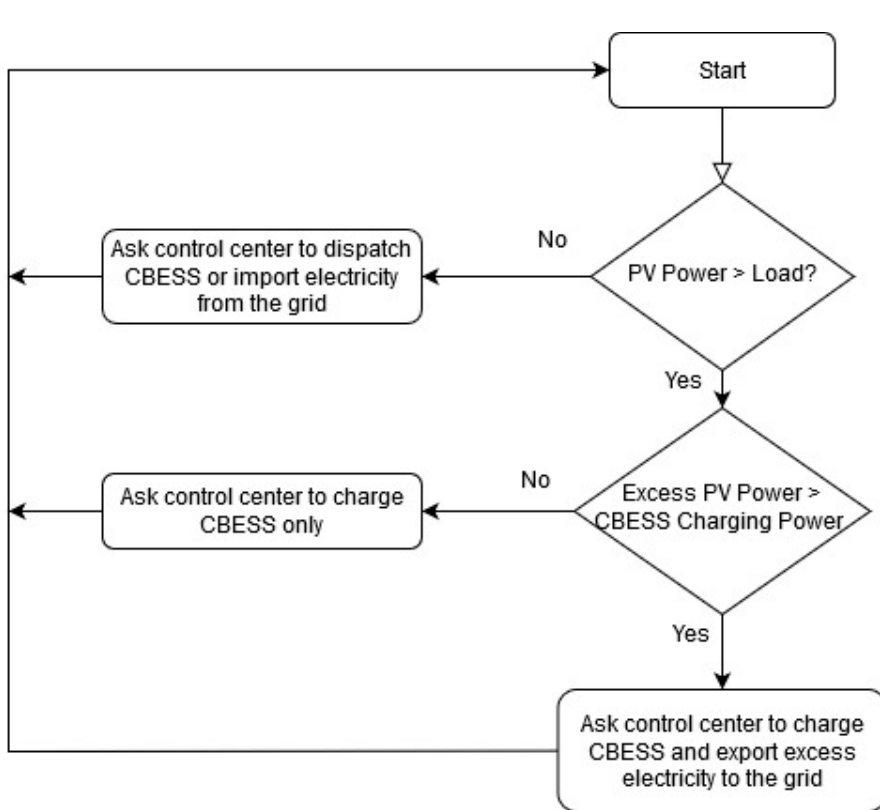
Figure A1. Flowchart for export and import from and to the grid.